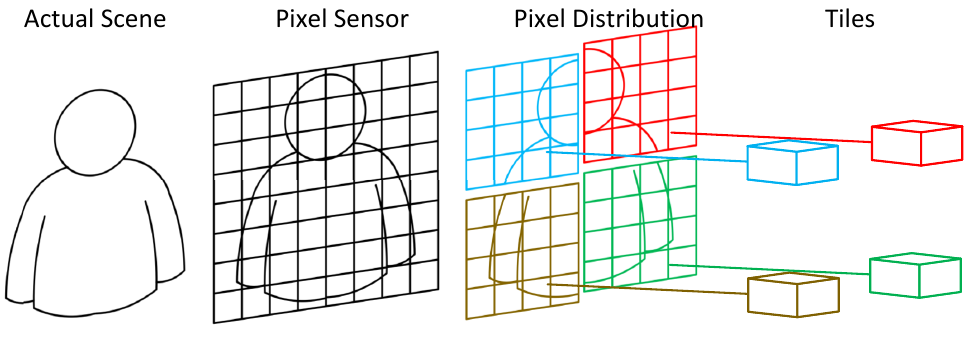
Figure 1. The intrinsic IP/CV parallelism explored using multiple processing